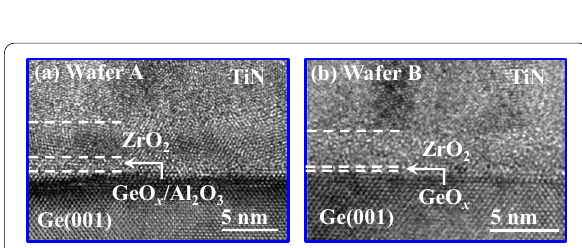
Fig. 2 HRTEM images of a TiN//ZrO 2 /Al 2 O 3 /GeO x /Ge, b TiN/ ZrO 2 / GeO x /Ge stacks for the devices on wafers A and B,